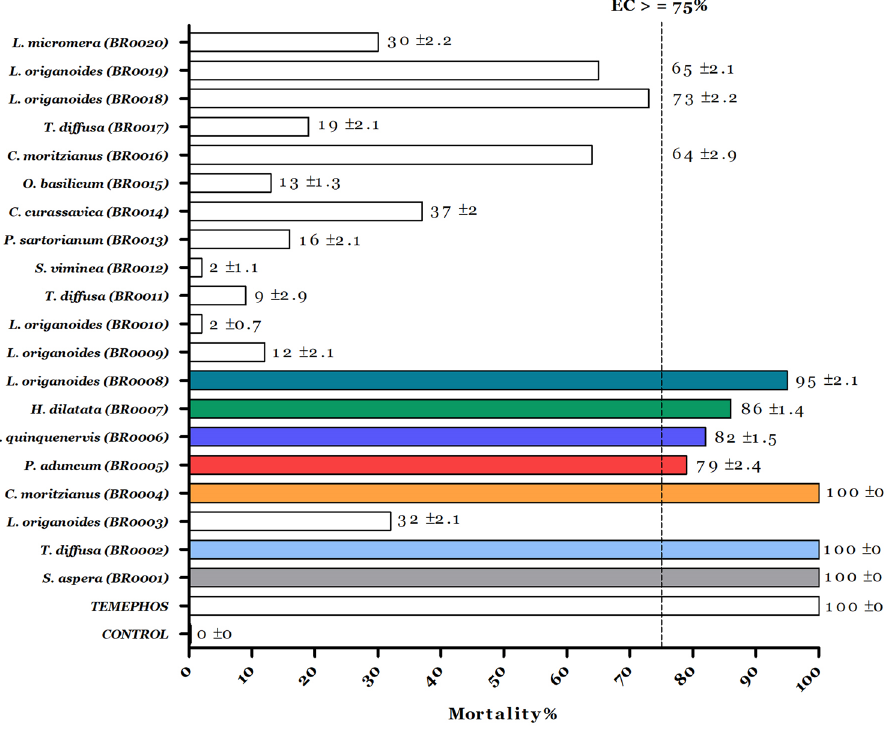
Figure 1. The essential oils mortality rate at the exploratory concentrations (EC) 100 µg/mL. The dashed line represents the activity threshold considered a promissory larvicide. Colored bars represent the promissory EOs as larvicide; temephos was used as a positive control with an LC 90 of 0.032 µg/mL.